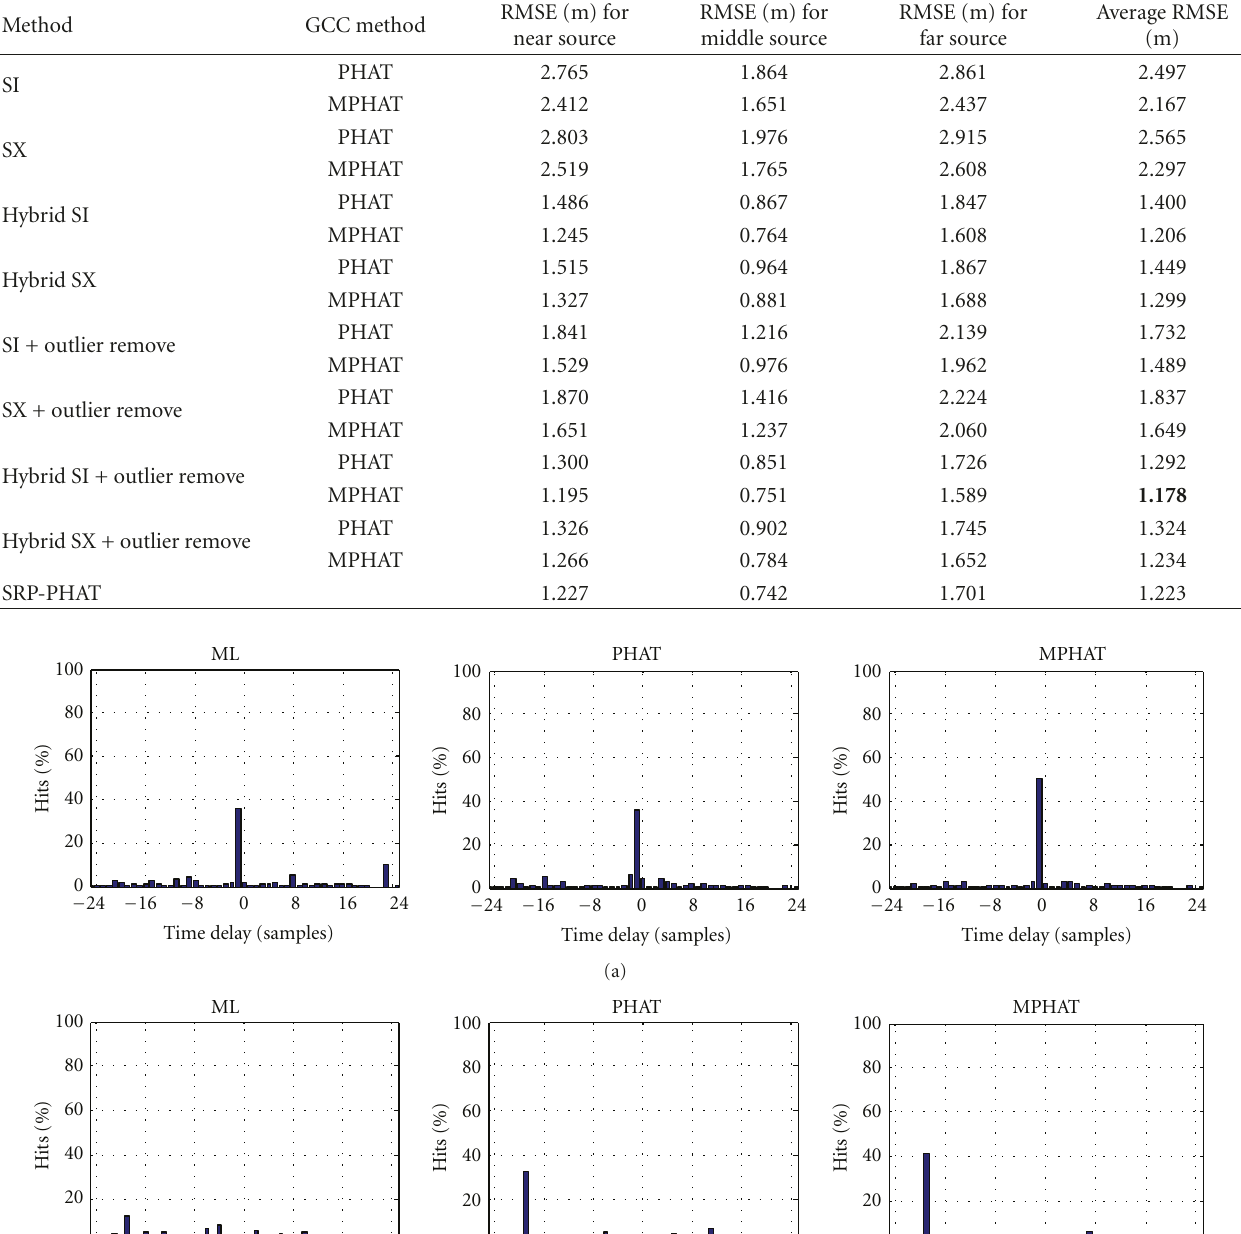
Table 2: Comparison between 3D RMSE of various speech source localization methods on real (practical) data.